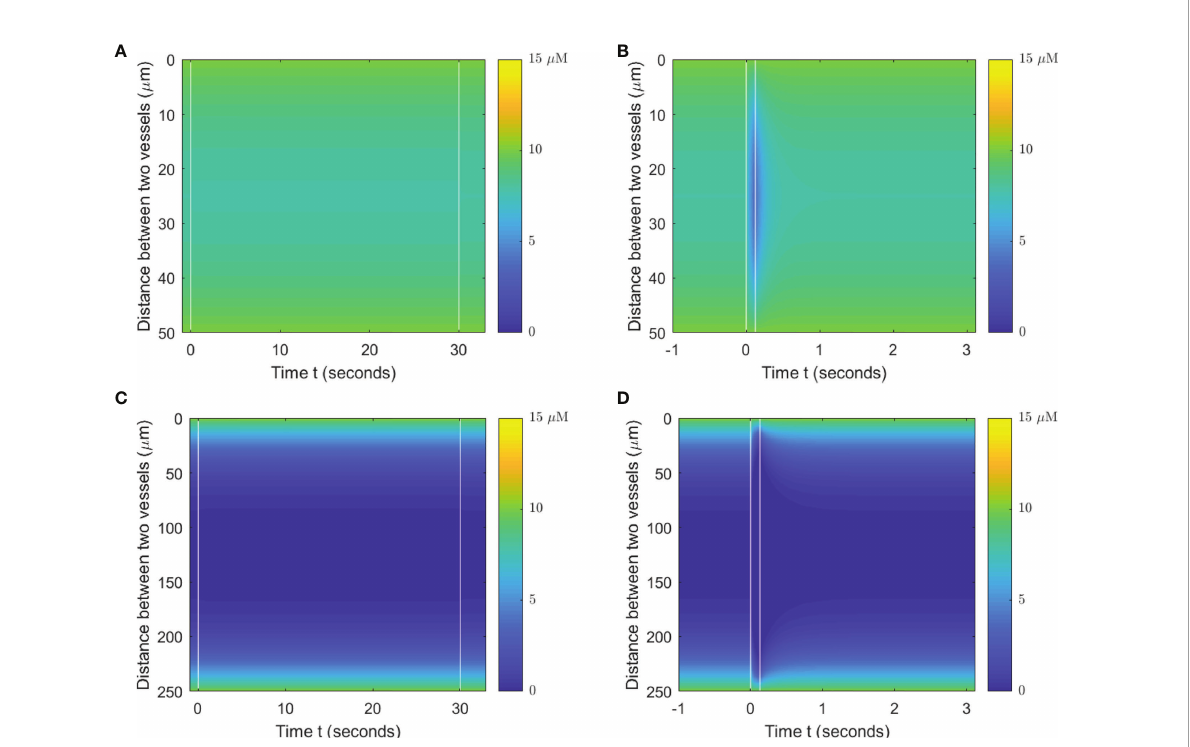
FIGURE 3 Spatiotemporal changes in oxygen levels for different vasculature spacings and dose rates. Oxygen levels ( m M) under 15 Gy irradiation with spacings of 50 m m (A, B) and 250 m m (C, D) under BC=10.1 m M. The time between two vertical white lines indicates the duration of the irradiation. (A, C) Irradiated with 0.5 Gy/s; (B, D) irradiated with 125